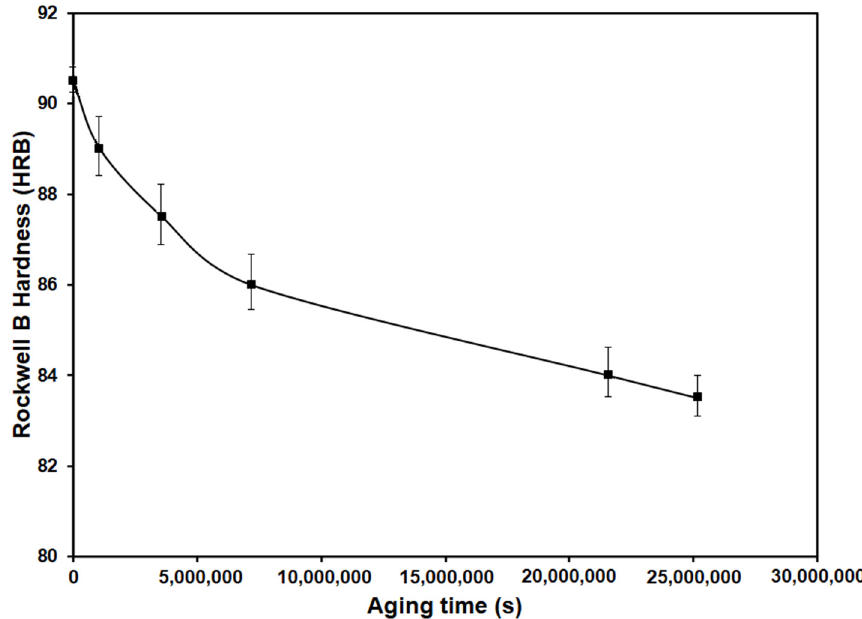
Figure 12. Plot of Rockwell “B” hardness vs. time for aging at 600 °C.